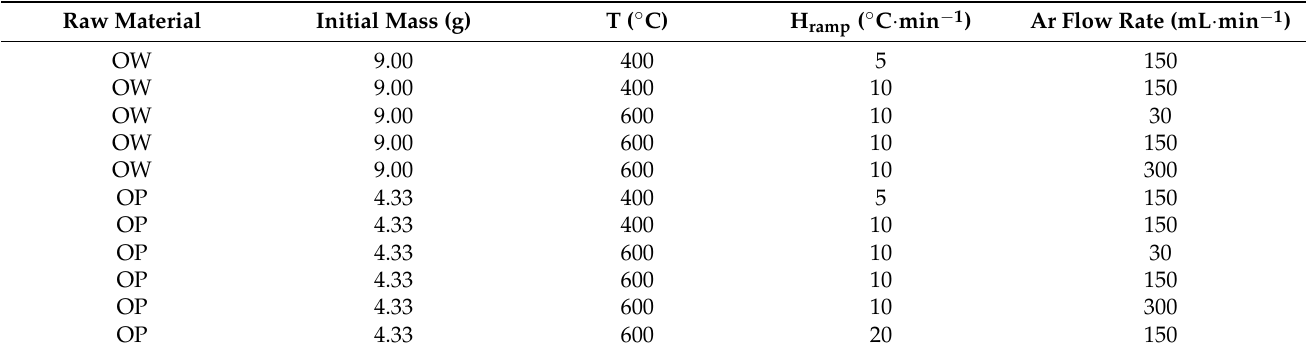
Figure 1. Pyrolysis equipment. Table 1. Pyrolysis conditions for orange pruning (OP) and orange waste